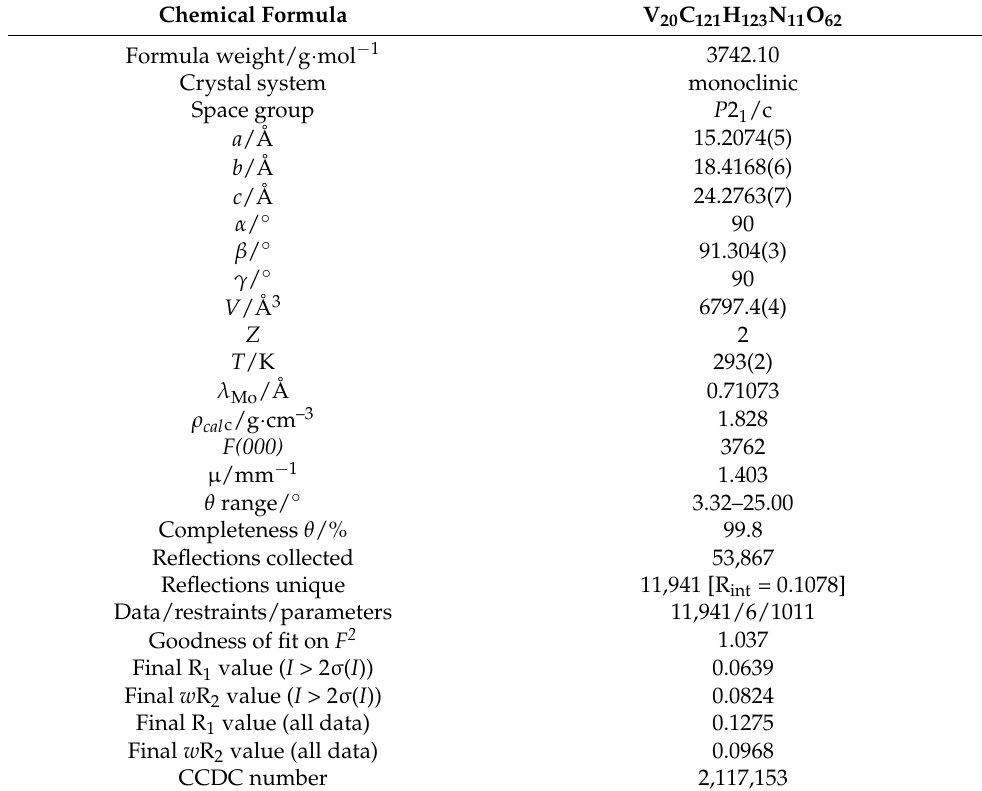
Table 1. Crystal data and structure refinement for the title